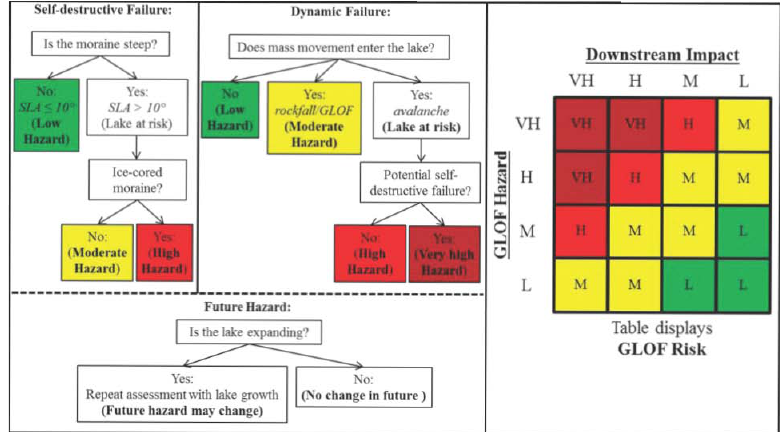
Figure 2. Hazard classification flow chart for dynamic and self-destructive failures and the GLOF risk chart as a function of hazard and downstream impacts.